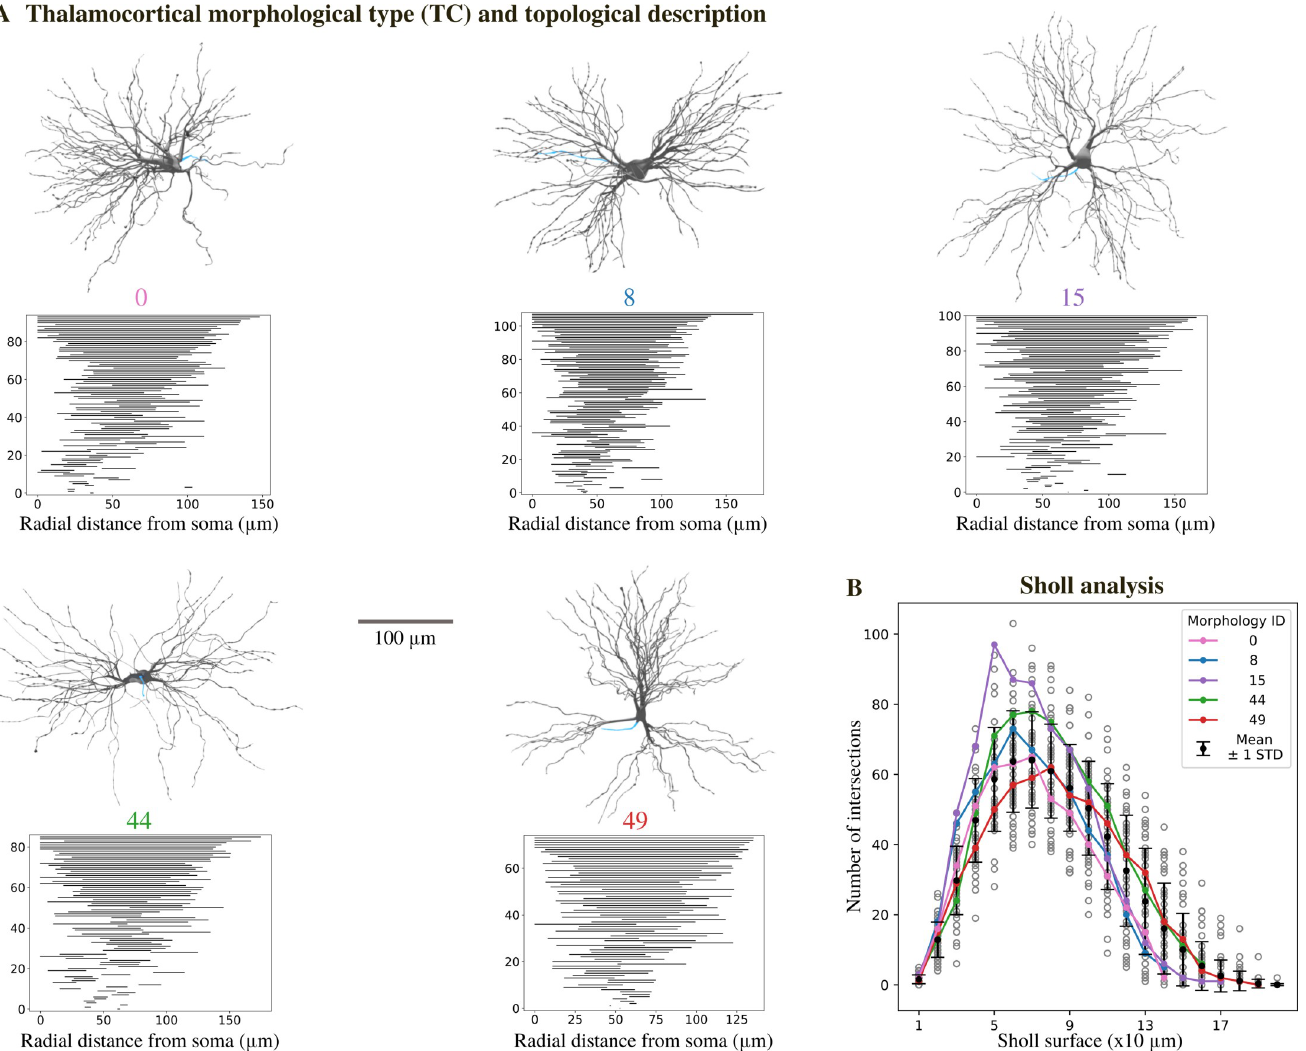
Fig 2. Morphological properties. (A) Renderings of 3D reconstructed TC neurons along with their persistence barcode. The persistence barcode is a topological description of the branching pattern of the neurons’ dendrites. Grey: soma and dendrites, blue: axon (only small sections available). (B) Sholl analysis of TC neuron dendrites. For each Sholl ring, the number of intersections is shown (mean ± standard deviation, N = 50). Each grey circle represents one morphology, colored lines correspond to the morphologies in A. See S1 Fig for further analysis.